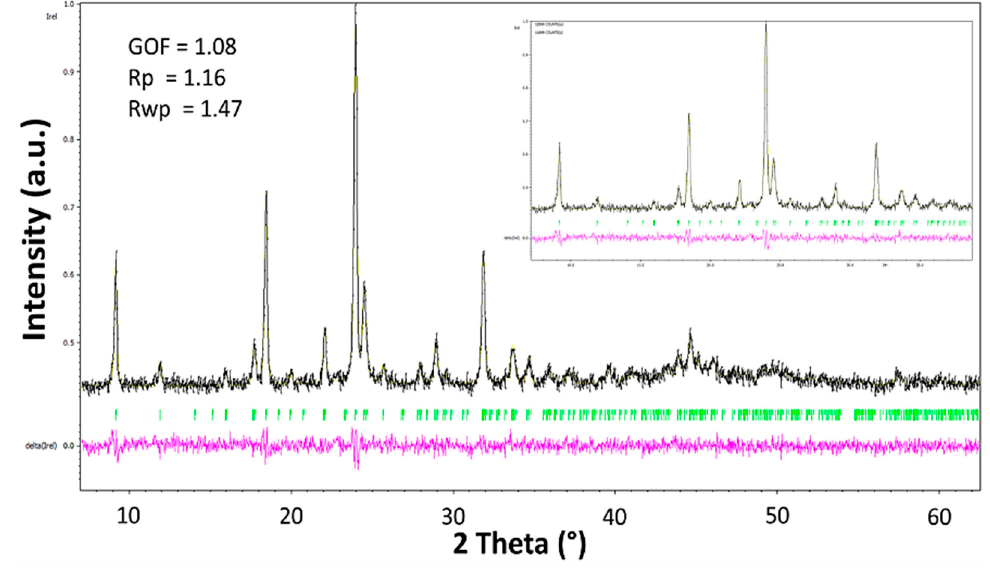
Figure 6. Graphical result of LeBail analysis after heat treatment of complex 1 at 130 °C.